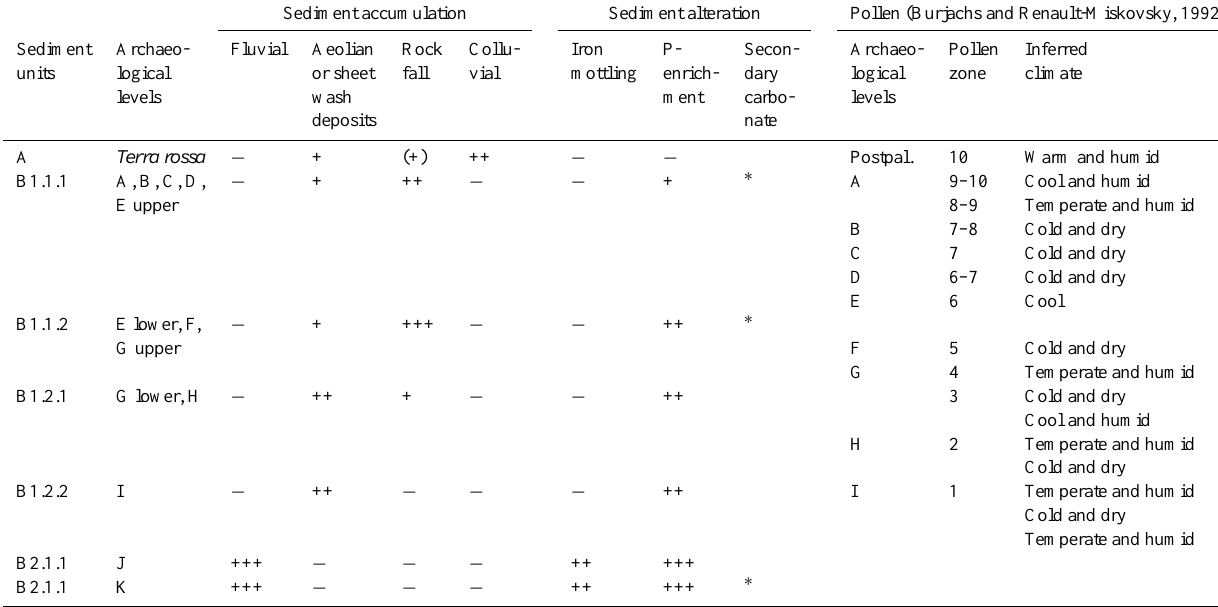
Table 1. Relative significance of selected accumulation and alteration processes in the north profile of square E 0 and correlation with the pollen zones and climate reconstructions of Burjachs and Renault-Miskovsky (1992, Fig. 3). The P enrichment is related to zoogenic inputs. Anthropogenic accumulation of lithics, bone or charcoal is low over the whole sequence, but find densities at Arbreda spatially varies.